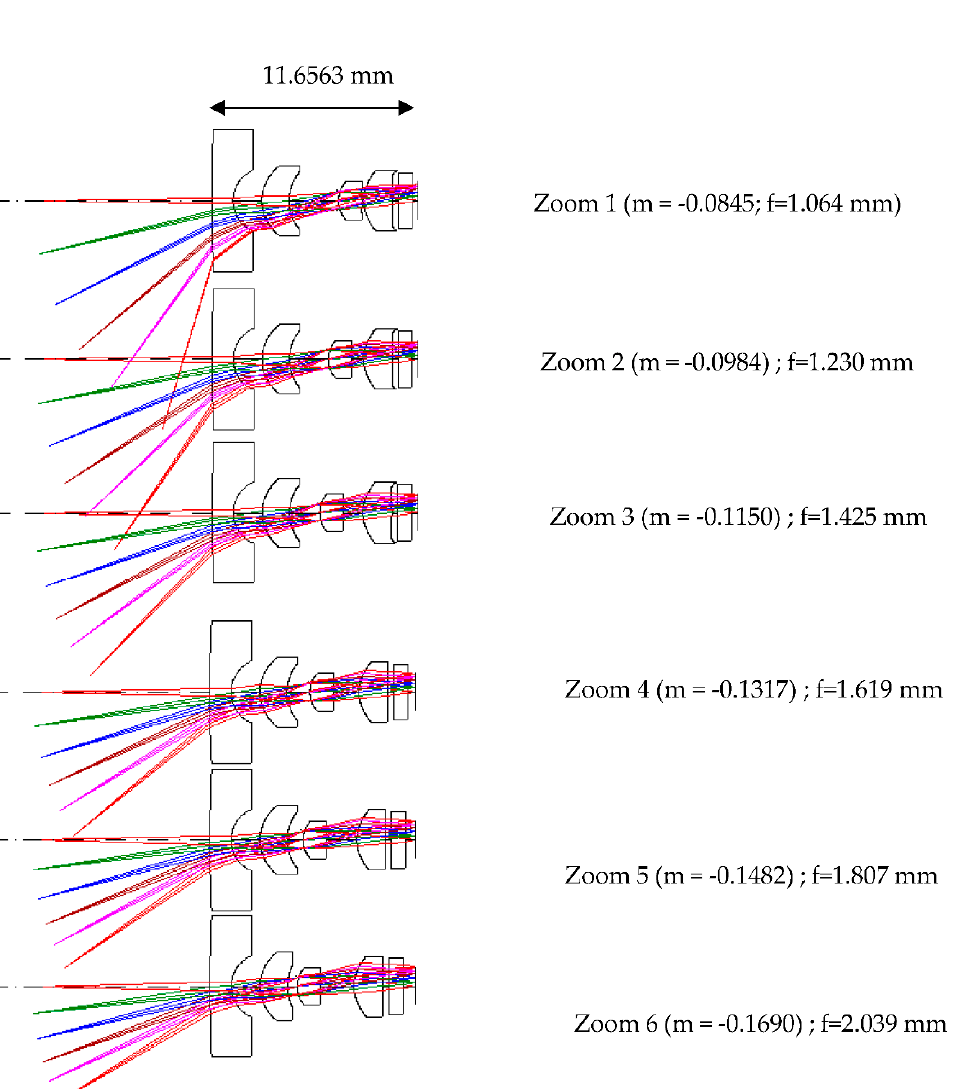
Figure 3. Trajectory diagram of a 2× zoom lens .